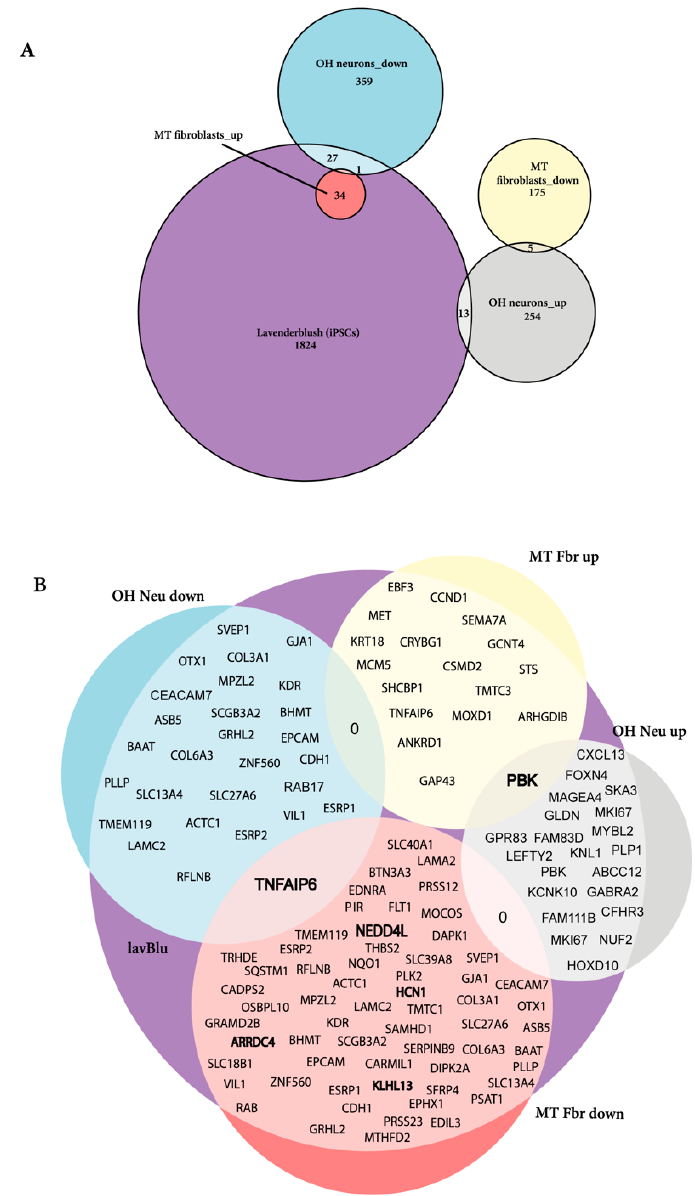
Figure 9. Venn diagram demonstrating the differentially expressed genes in iPSC-derived neurons and fibroblasts. ( A ) The number of genes in each data set and whether they are up or down regu- lated are shown where the size of the circles represents the relative proportion of those genes that correspond to the genes in the preserved module. ( B ) Diagram showing the genes preserved from lavendersblush across neurons and fibroblasts. Fbr up/down stand for fibroblast (MT) genes up or down regulated (bolded genes represent ubiquitination related genes), OH Neu down/up represent the iPSCs derived neurons (OH) and lavBlu represents the lavenderblush module obtained in the iPSCs.